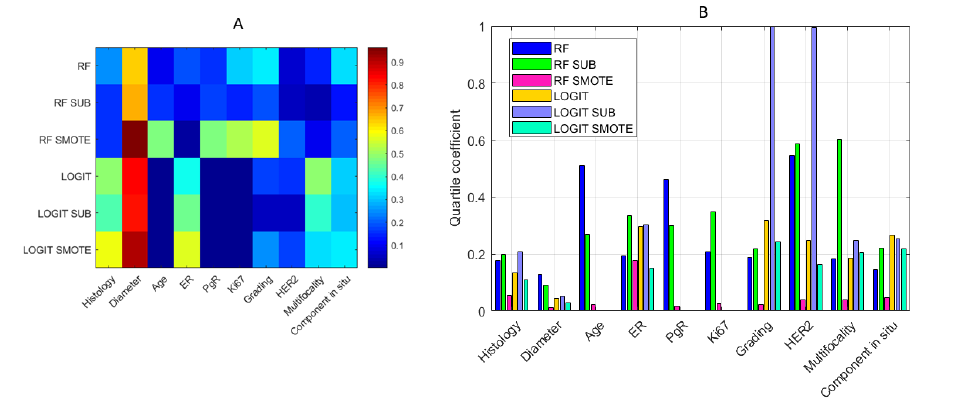
Figure 4. ( A ) Importance scores of the features averaged across the rounds to obtain a single feature importance vector for each classification scheme. ( B ) Variability across rounds of each feature for each classification scheme expressed as the quartile coefficient of